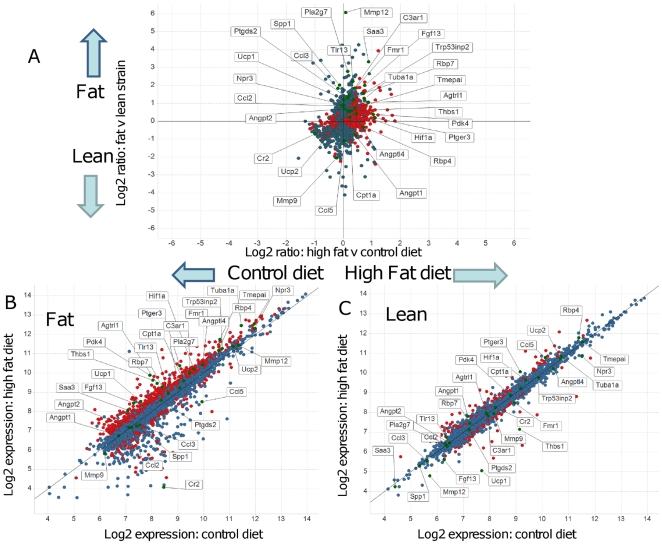
Differential gene expression in subcutaneous adipose tissues of Fat and Lean mice exposed to control or high fat diets.
A. Log (base 2) ratios of gene expression intensities in fat and lean mice on the high fat and control diets. The y-axis shows the comparison of fat and lean strains regardless of diet. The x-axis compares high fat and control diets regardless of strain. Red spots represent genes that are significantly differentially expressed in Fat mice on high fat diet compared to control diet. Several genes of interest with higher expression in Fat mice and on a high fat diet are marked and labelled. B. and C. Log (base 2) gene expression intensities in (B) Fat mice and (C) Lean mice on the high fat and control diets. For each strain, the y-axis shows the log2 expression in high fat fed mice. The x-axis is for control diet. Red spots represent genes that are significantly differentially expressed in high fat diet compared to control diet for each strain. Several genes of interest discussed in the text are marked and labelled on graphs for both strains. Genes expressed below the arbitrary threshold (100) throughout the experiment were removed for clarity.